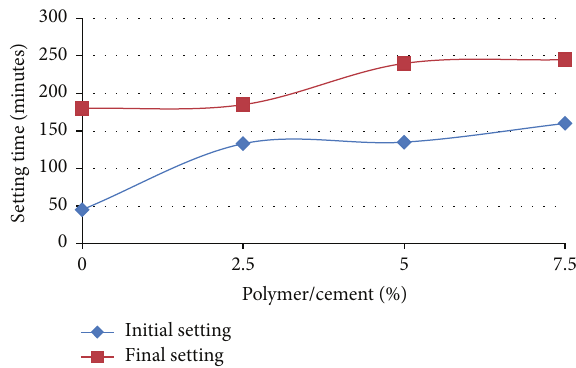
Figure 6: 28-day compressive strength of the concrete containing 5% polymer and 15% MK.